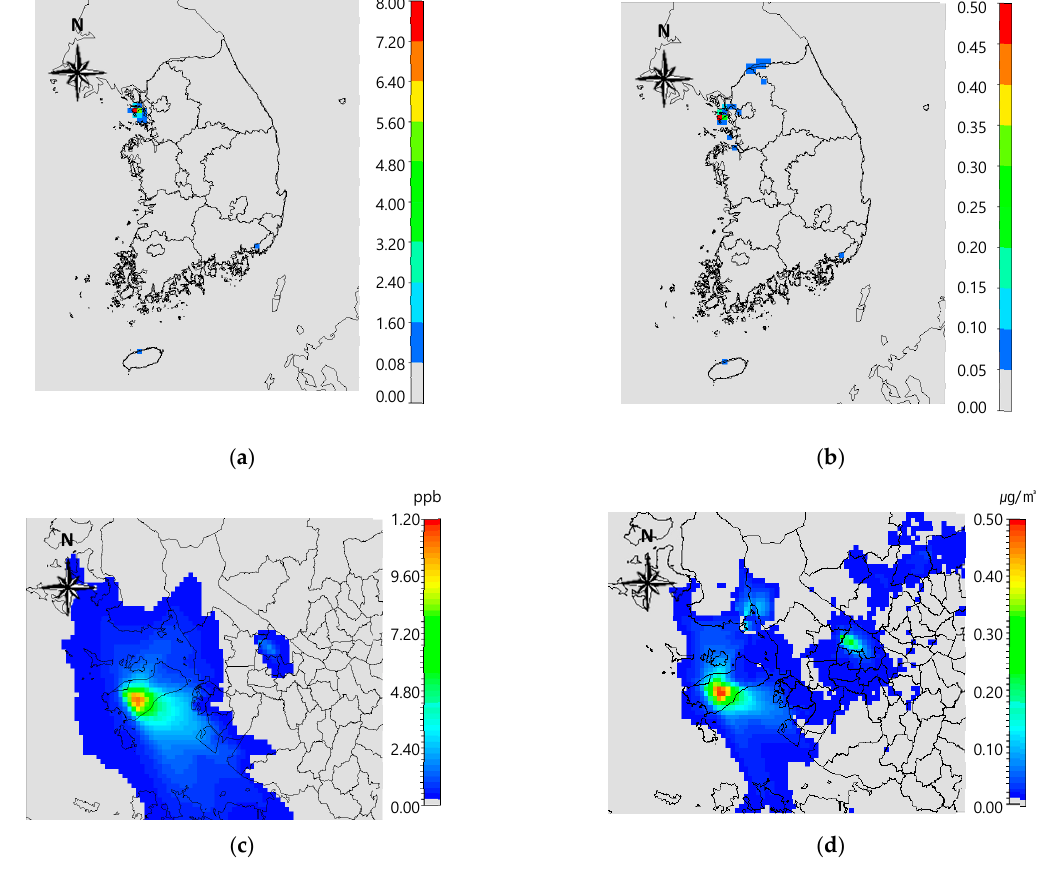
Figure 4. Changes in NO 2 between BAU and COVID scenario for nationwide domain ( a ) and airport area domain ( c ). Changes in PM 2.5 between BAU and COVID scenario for nationwide domain ( b ) and airport area domain ( d ).